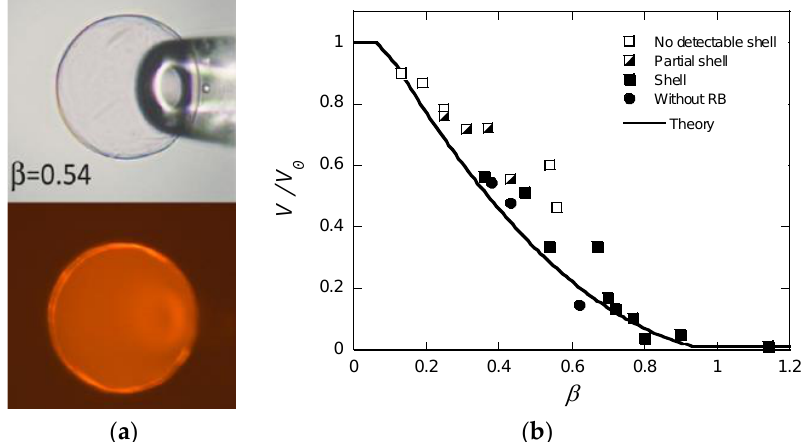
Figure 16. ( a ) Microscopy images of PA-microgel in a solution of C 12 TABr in 10 mM sodium phosphate buffer obtained with the micropipette/micro-droplet technique. Lower figure shows a fluorescence microscopy image with a small amount of a fluorescent dye dissolved in the micelles; ( b ) swelling isotherms for the same system. Microgel volume ratio (V/V 0 ) is plotted vs. the charge ratio between the surfactant and network (β). The solid cure is the prediction by the theory of G&H. Data taken from ref. [60]. Reprinted with permission. Copyright 2016 American Chemical Society.